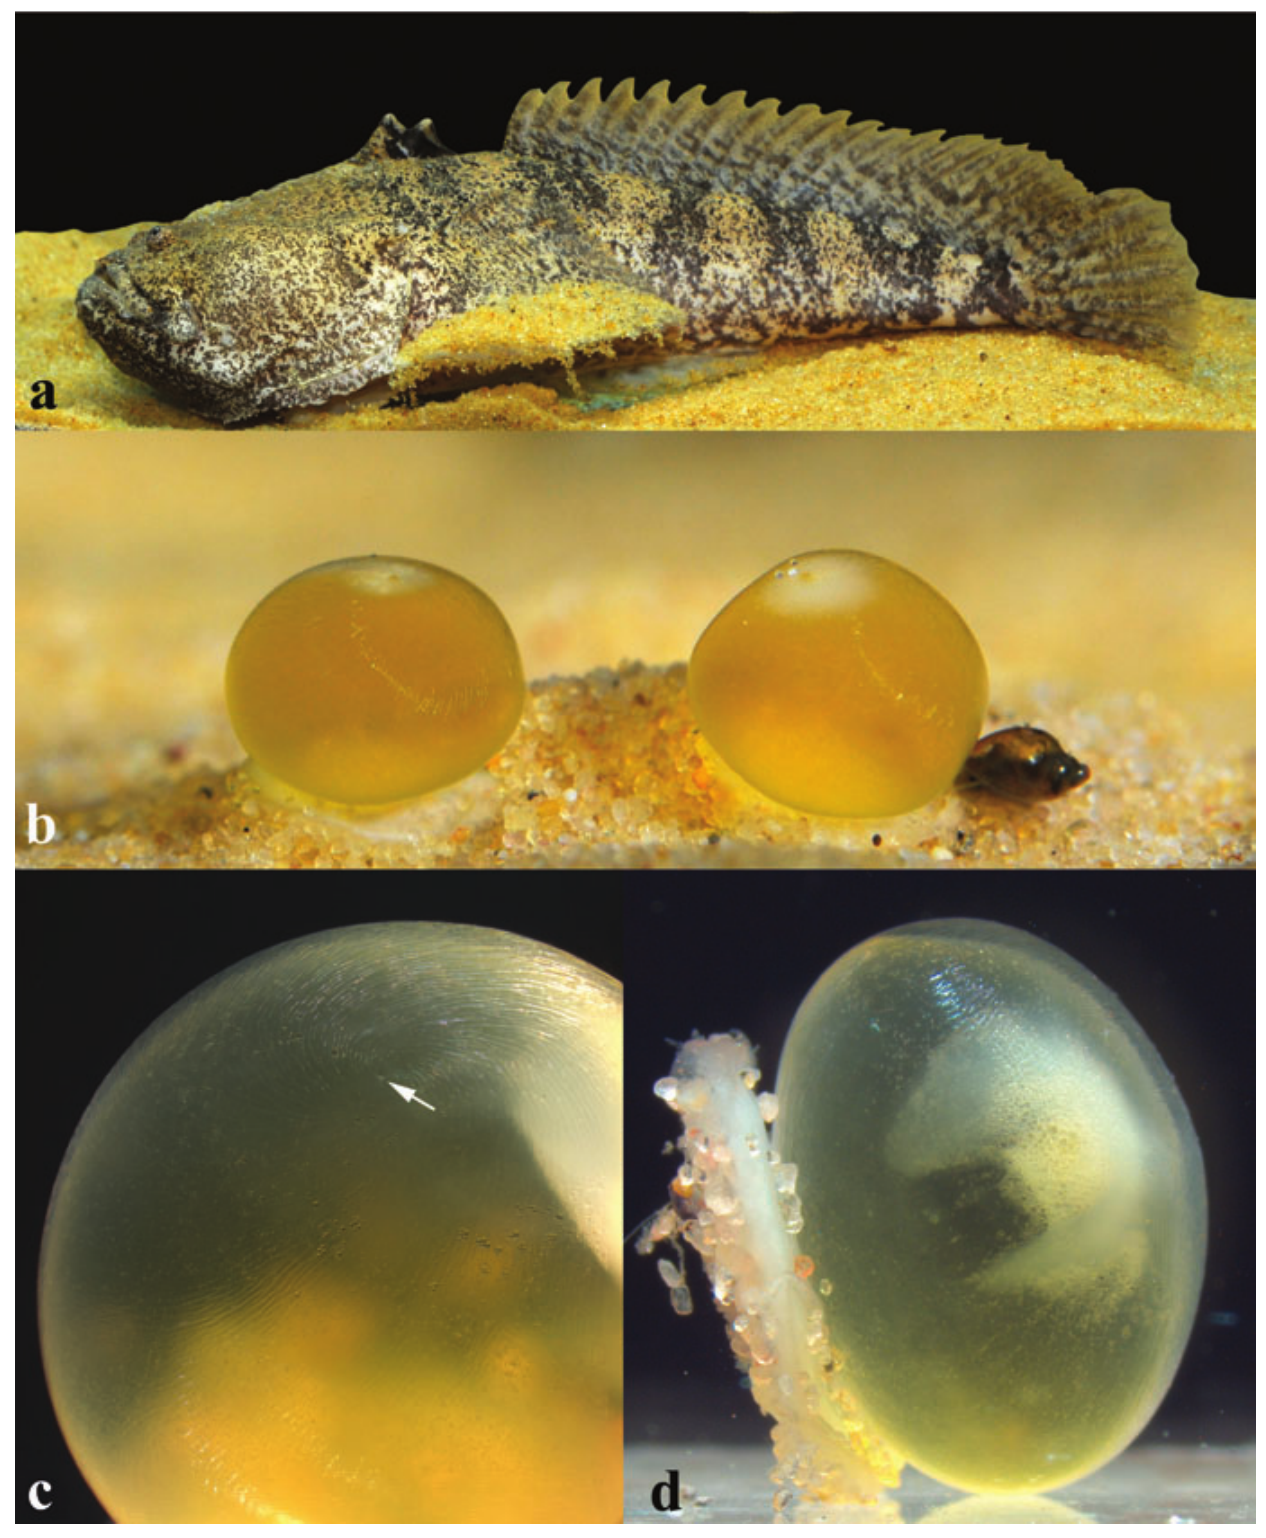
Fig. 1. a , An adult individual of Thalassophryne amazonica . Note the two erected dorsal fin spines, the large pectoral fins, and the confluence of dorsal and caudal fins. b – d , spawned eggs of T. amazonica . Eggs are ellipsoid and relatively large with a large amount of yolk. They sit on top of the sand with the aid of their whitish adhesive foot. Note spiralling pattern clearly visible at 40-times magnification with light microscopy. Arrow in c points to